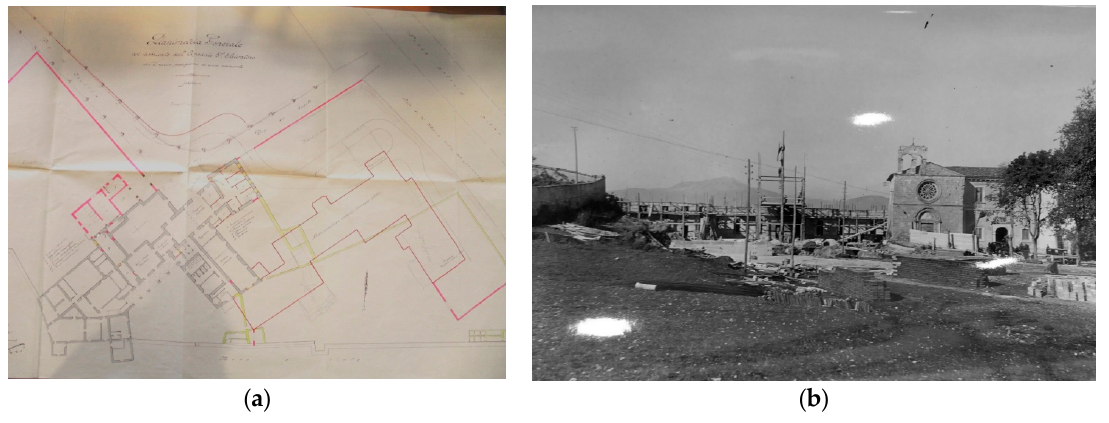
Figure 4. The expansion project of 1931: ( a ) The general plan of the first project/design hypothesis (Cfr. ASA, Comune Aq, cat. X, cl. II (1906–1940): Lavori al civico Ospedale di San Salvatore. Drawings highlighting the “old structures” and the new hospital plan with an explanatory report, 25 April 1931, Eng. R. Inverardi); ( b ) The construction yard.